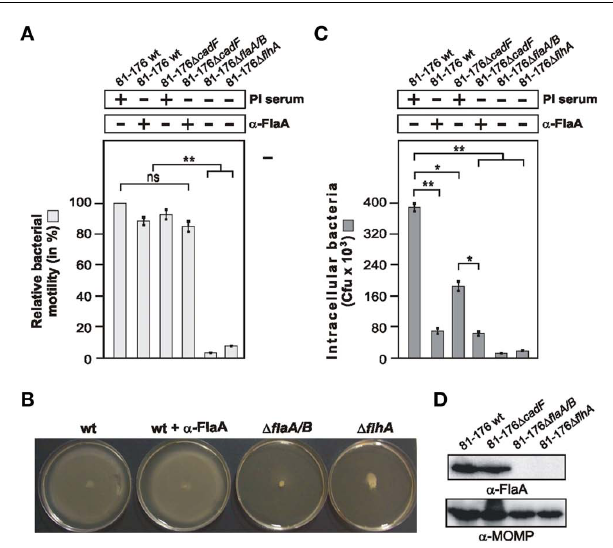
FIGURE 8 | Different effects of an α -FlaA antibody on C. jejuni motility and host cell invasion. (A) Quantification of motility using the indicated WT and mutant strains in the presence of 20 μ g/ml α -FlaA antibody or pre-immune (PI) serum as control. One hundred percentage of motility corresponds to the highest motility presented by C. jejuni WT strain 81–176. (B) Examples of motility phenotypes with indicated strains. (C) INT-407 cells were infected with the indicatedWT and mutant strains for 6h in presence or absence of 20 μ g/ml α -FlaA antibody or PI serum as control. Intracellular Campylobacter cells were quantified by gentamicin protection assays. (D) The α -FlaA immunoblot shows that flagellin is expressed inWT and Δ cadF C. jejuni , but not in flagellar mutant bacteria.The α -MOMP immunoblot served as loading control. ∗ p < 0.05 and ∗∗ p ≤ 0.005 were considered as statistically significant as compared to the